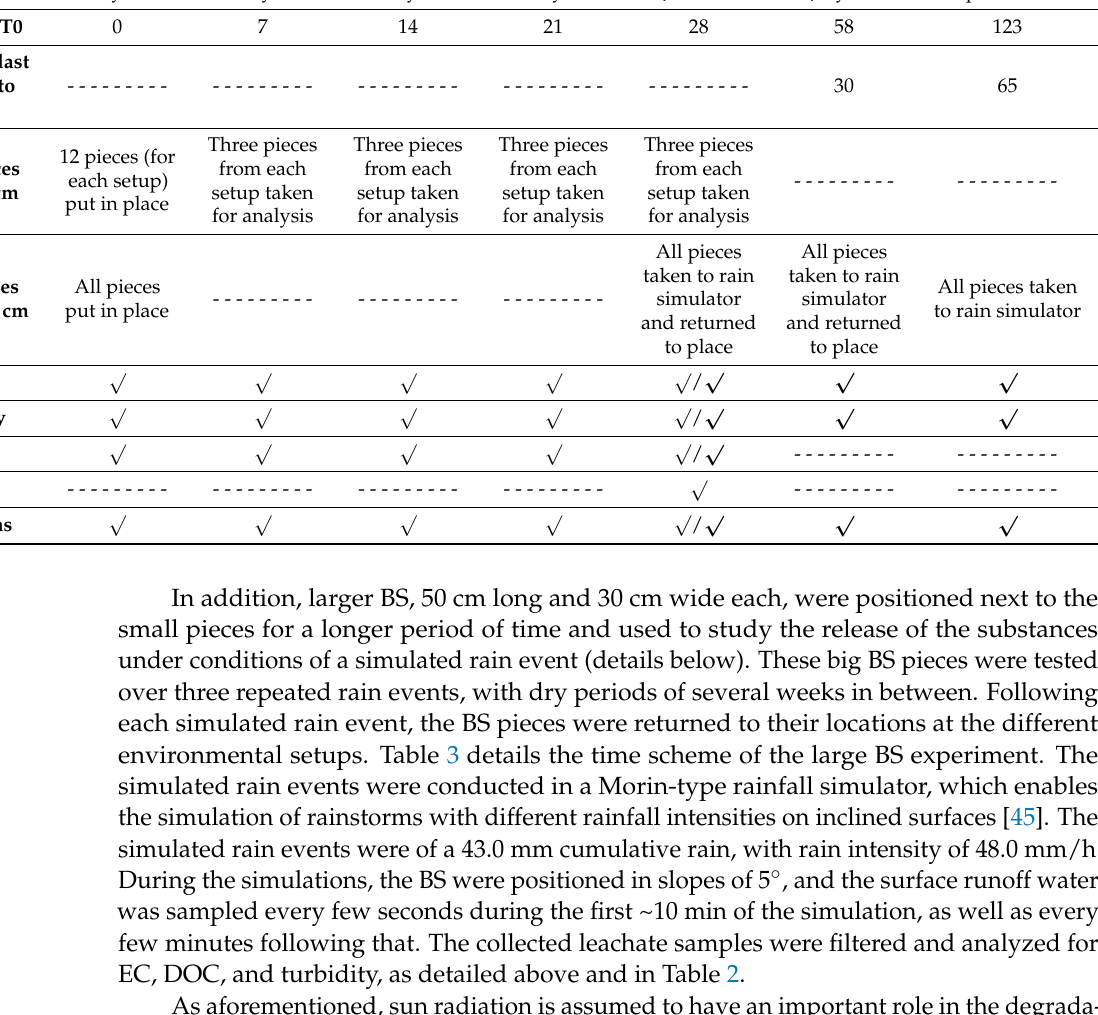
√ √ / ) indicate operations on the small and